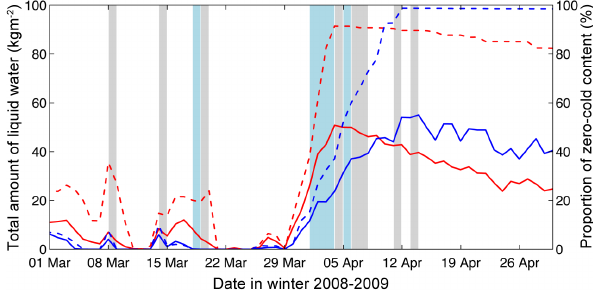
Fig. 8. Daily maximum amount of liquid water within the snow- pack for a south-facing 35 ◦ slope at 2200ma.s.l. (red solid line) and 2500ma.s.l. (blue solid line). Dashed lines show proportion of snowpack with a zero cold content (red = 2200m; blue = 2500m). The grey boxes indicate periods with wet-snow avalanche activ- ity (AAI > 2) recorded for the surroundings of Davos, Switzerland, blue boxes indicate major wet-snow avalanche cycles (AAI > 30, Table